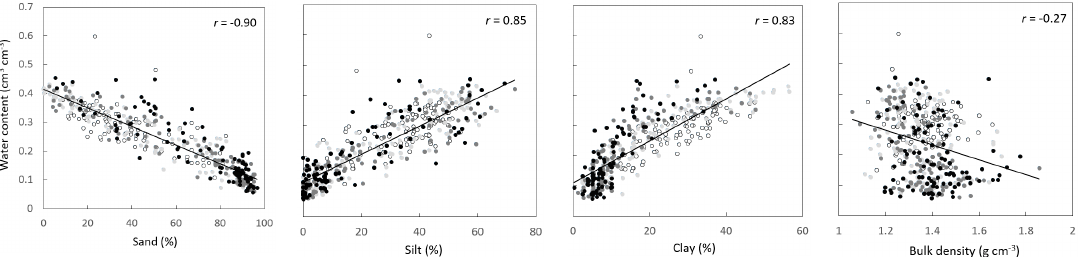
Figure 4. The relationship of 400 samples at four depths from 0–1 meter of soil texture (% Clay, Silt, & Sand) and bulk density (BD) to volumetric water content from a 73-ha two-pivot field in west Tennessee. The light to darker colors of the data markers correspond to 0 – 1 meter depths.